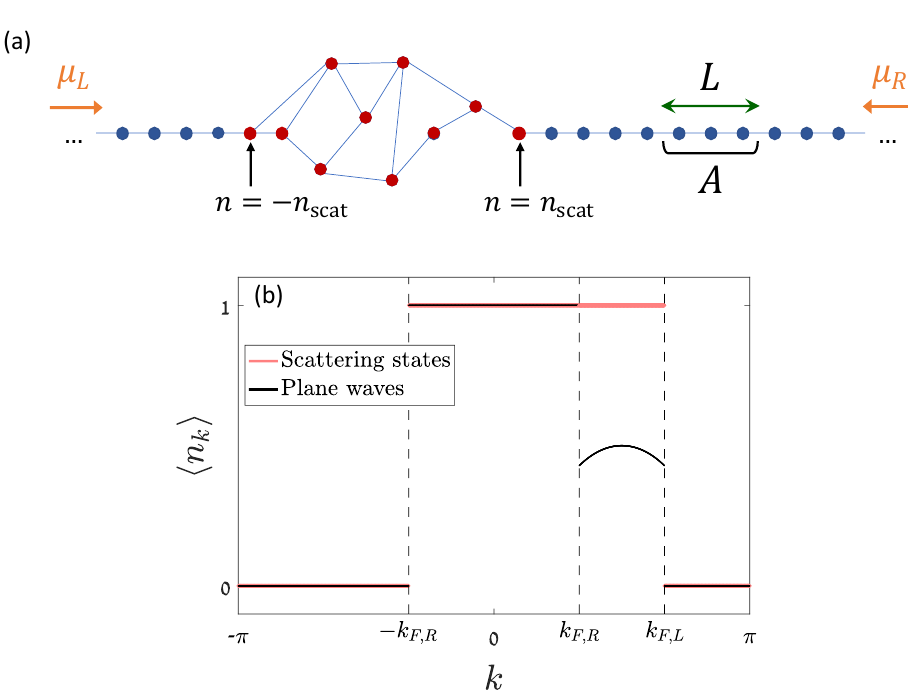
Figure 1: (a) Schematic illustration of the general lattice model under consideration in Secs. 2–3, with the single-particle Hamiltonian given in Eq. (7). Sites marked in blue belong to the unperturbed parts of the tight-binding chain, while sites marked in red belong to the scattering region, which terminates at the sites n = ± n . µ L scat ( µ ) designates the chemical potential for particles incoming from the left (right). R A denotes the subsystem of L contiguous sites with respect to which the calcula- tions of bipartite entanglement in Sec. 3 are performed. (b) Schematic plot of the distributions as functions of lattice momentum, for the scattering states (defined in Eqs. (9)–(10)) and for plane waves (in the region n > n , to the right of the scat- scat > k tering region). The case shown is k F , L F , R